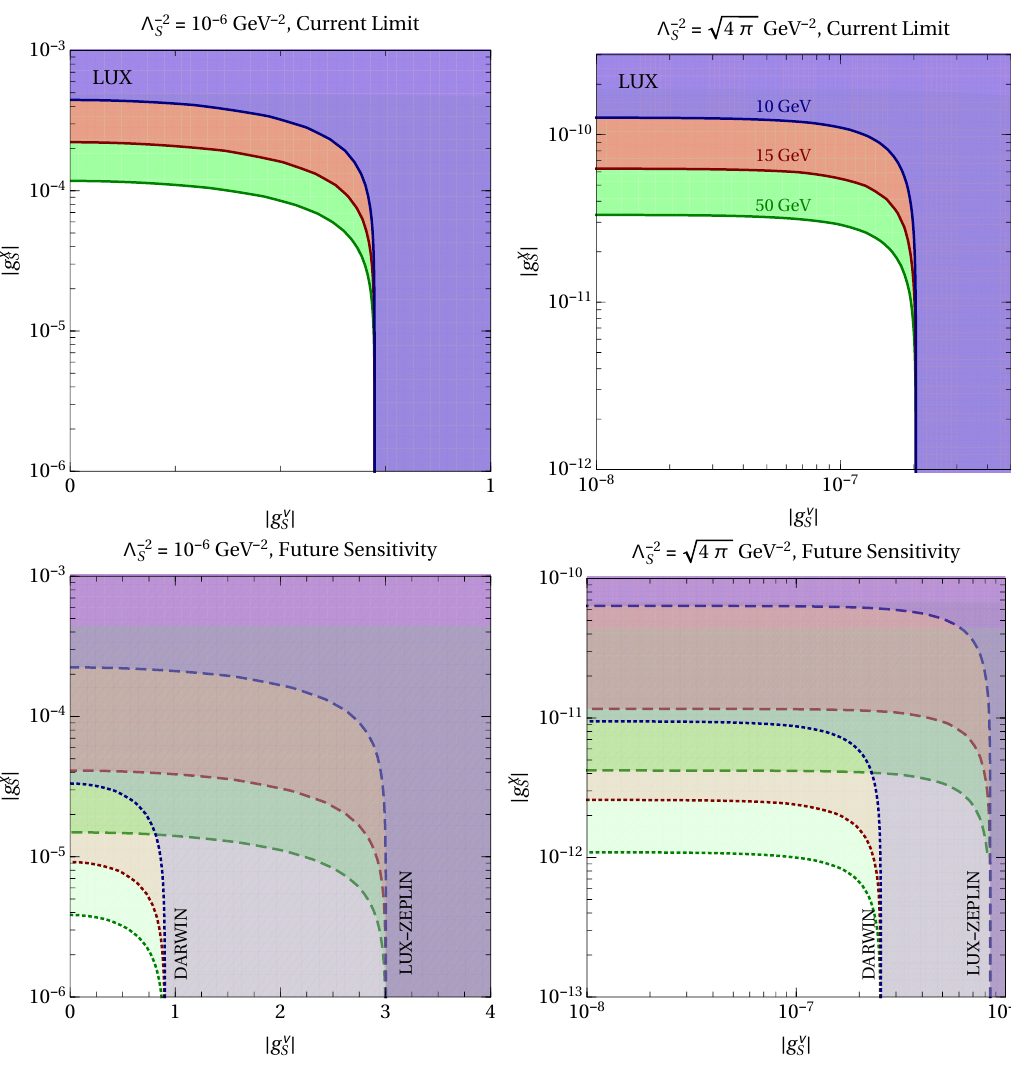
Figure 3 . Current limits (top panels) and future sensitivity (bottom panels) on the parameters of the scalar model. The coloured region can be excluded at 90% C.L. by current LUX data [44] (con- tinuous lines) and by the future LUX-ZEPLIN [42] (dashed lines) and DARWIN [43] experiments (dotted lines). The plots are for m (cid:31) = 10 GeV (violet), 15 GeV (red) and 50 GeV (green) for